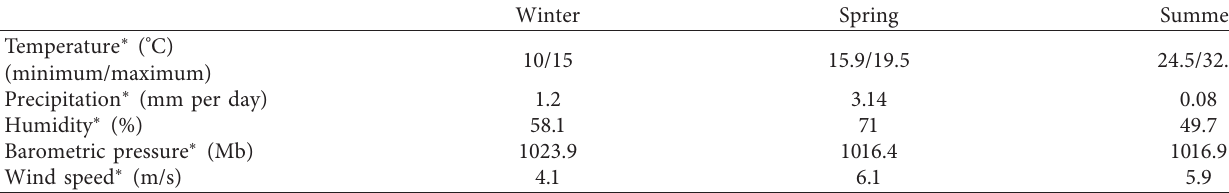
Table 1: Average means of meteorological parameters of the three seasons during the study time.